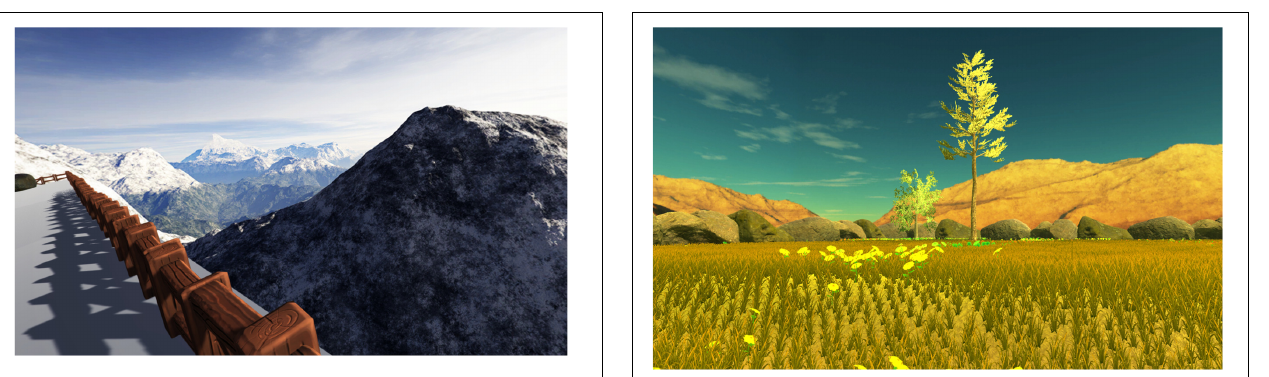
FIGURE 4 | The Neutral environment: green